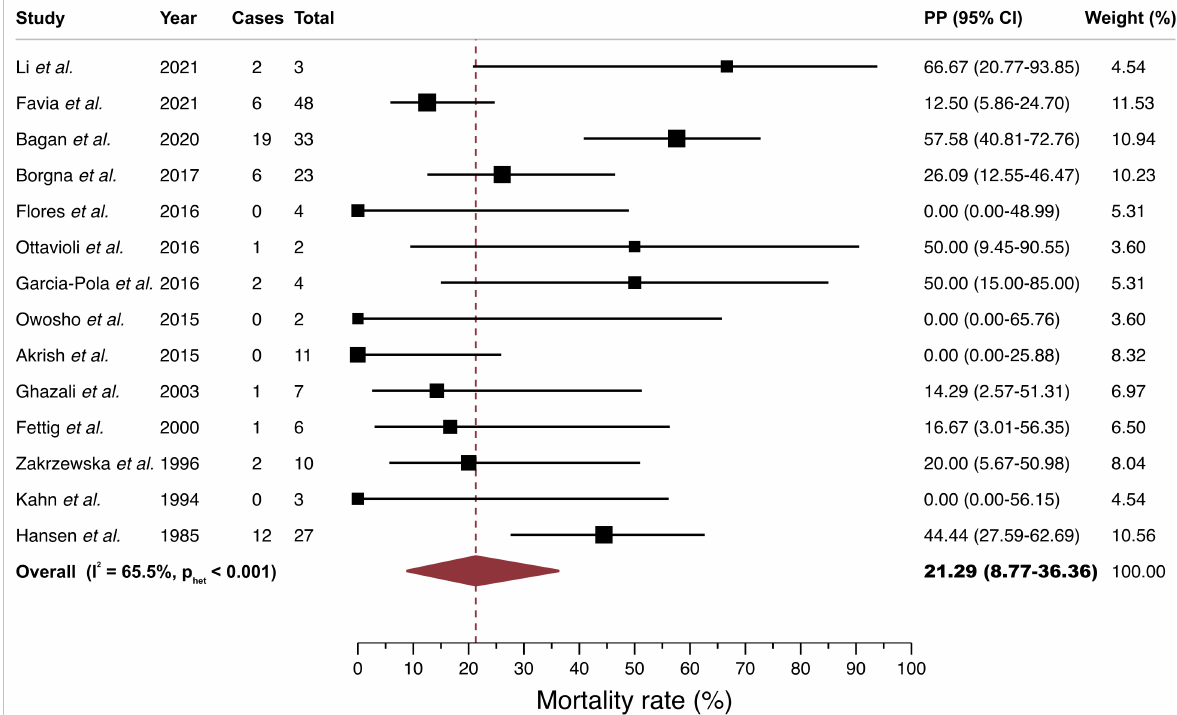
Figure 3. Forest plot graphically representing the meta-analysis of the mortality rate in PVL-OC. Random-effects model, DerSimonian, and Laird method. Pooled proportions (expressed as percentage) were used as effect size measure (expressed in bold). PP, pooled proportions; CI, confidence intervals; PVL-OC, oral carcinomas developed in patients with proliferative verrucous